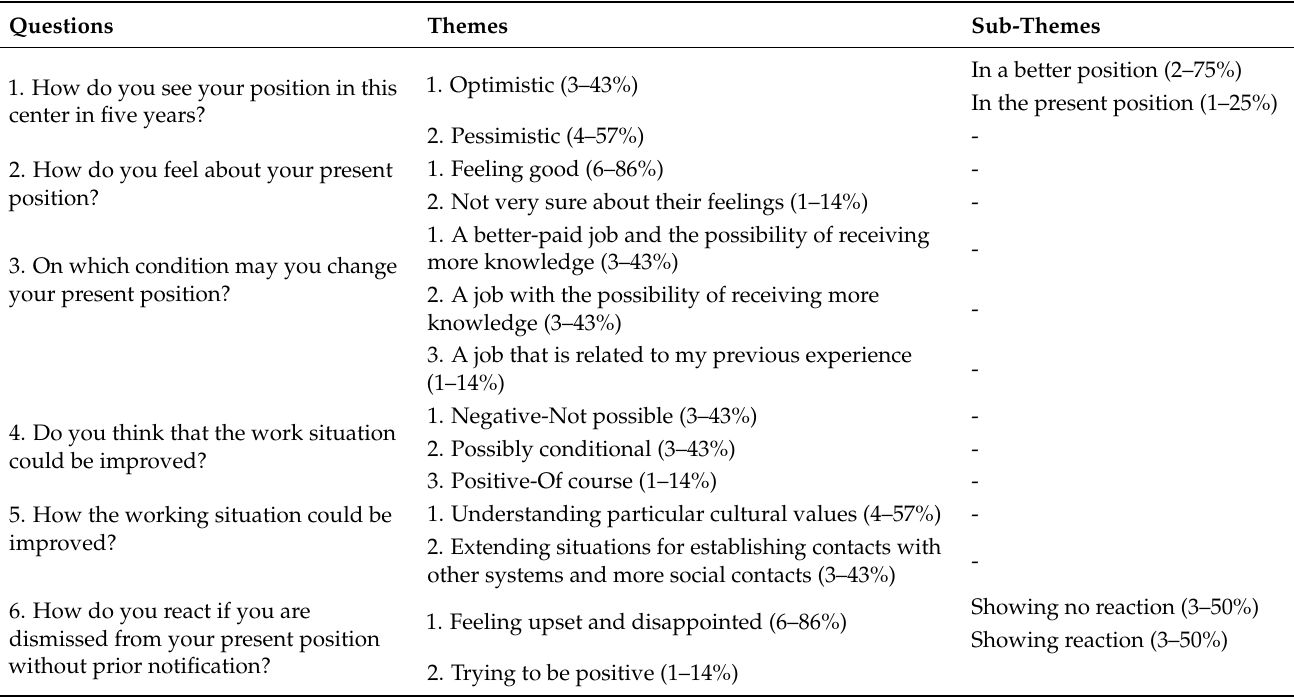
Table 3. Interview questions and extracted themes and sub-themes and their